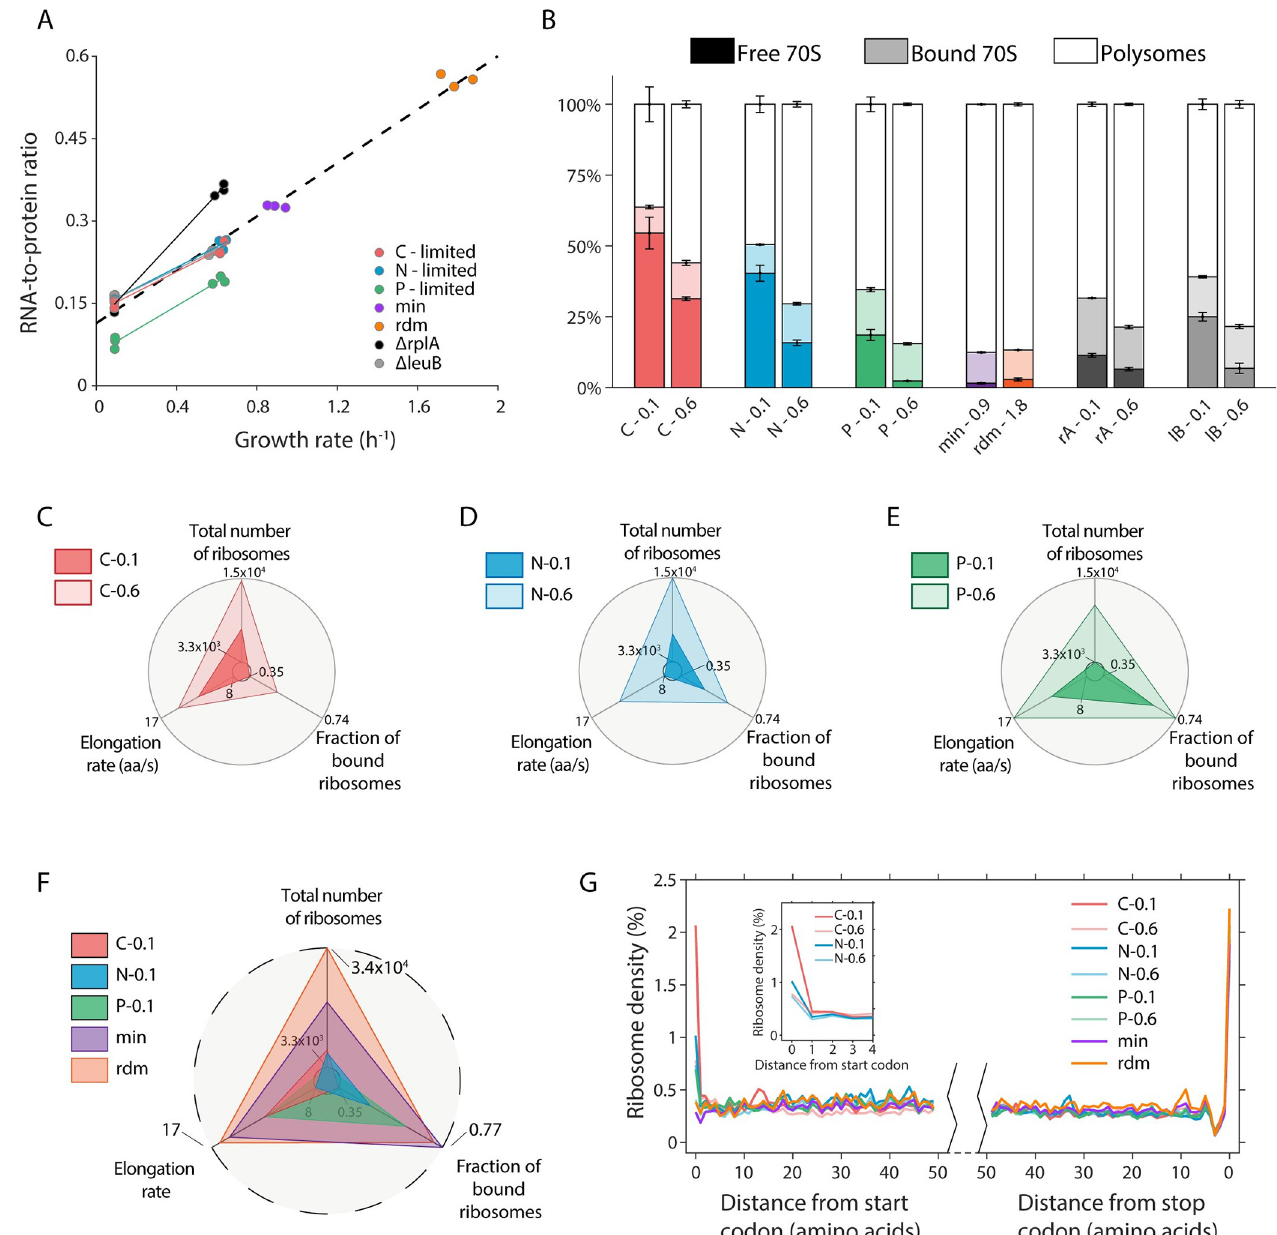
Fig 1. Cells adapt to nutrient conditions through different ribosomal strategies. (A) RNA-to-protein ratios for 12 conditions at different growth rates. Each data point represents one experimental measurement. (B) Fractions of assembled (70S) ribosomes under 12 conditions. The assembled ribosomes include free 70S monosomes, mRNA-bound 70S monosomes, and mRNA-bound 70S polysomes (multiple ribosomes on one mRNA). Free 70S, bound 70S, and polysomes are represented in dark, light, and white colors, respectively. The bar heights represent mean values with error bars indicating s.e.m. from three biological replicates. (C-E) Cells differentially regulate three ribosomal features in response to C-, N-, and P-limitations at the growth rates of 0.1 and 0.6 h -1 . The three features include total number of ribosomes per average cell (see Methods), elongation rate, and fraction of bound ribosomes. These features are scaled linearly between the inner circle and the outer circle, which represent the minimum and maximum among all conditions, respectively. The scales of the three indicated axes are the same for panels C-E. (F) Same as (C-E), but showing the differences between chemostat cultures and two batch conditions. The value of the outermost circle is larger than in C-E, especially the total number of ribosomes. (G) Averaged A-site ribosome density within the first and last 50 codons of the transcripts, from ribosome profiling analysis. Each curve shows the mean value from three replicates at each condition. Inset: ribosome density at the beginning of the